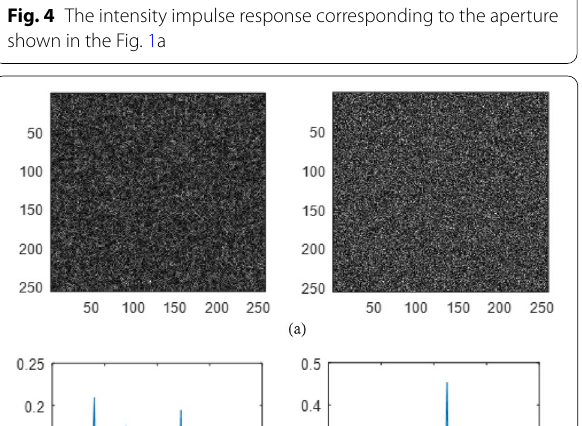
Fig. 4 The intensity impulse response corresponding to the aperture shown in the Fig. 1a